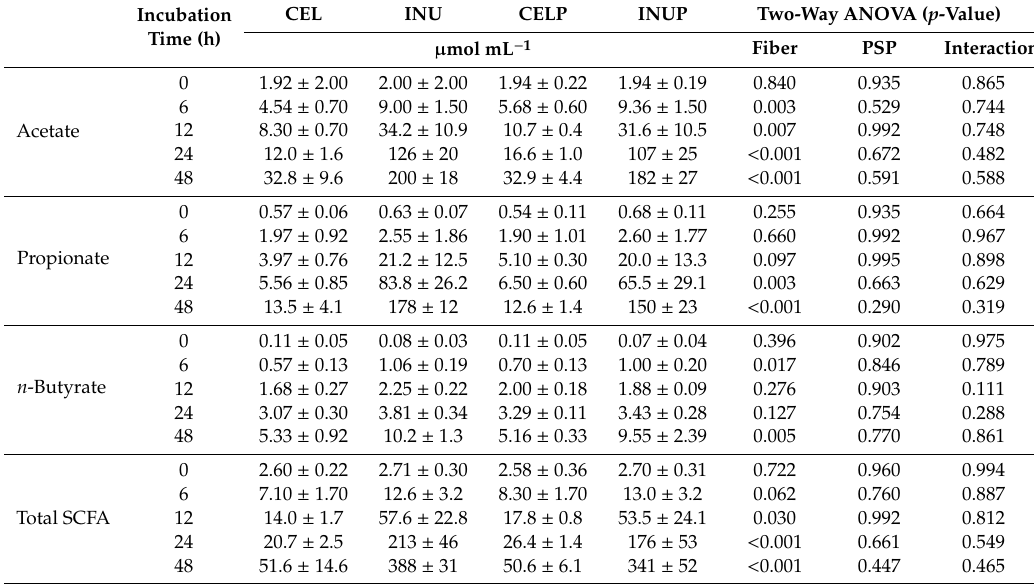
Table 2. Changes in short chain fatty acid (SCFA) during in vitro fecal